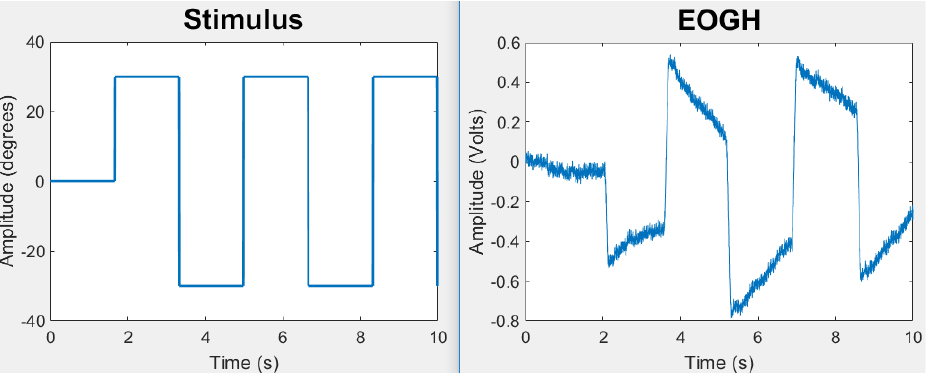
Figure 2. Example of a saccadic stimulus signal ( left ) and the EOG response acquired in the horizontal lead ( right